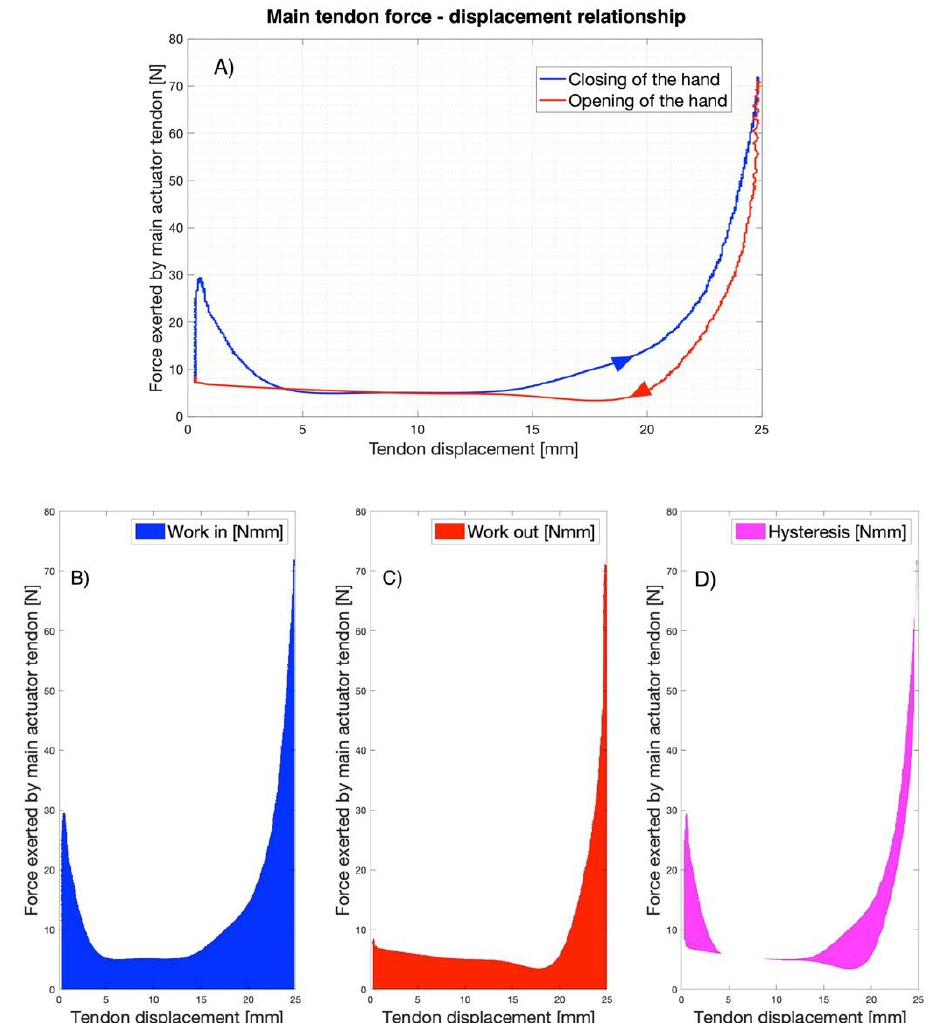
Figure 18. Main tendon force–displacement relationship ( A ) A whole cycle of hand closing (blue line) and opening (red line), the arrows indicate the direction of travel; ( B ) The blue area is the work required for closing the hand (work in); ( C ) The red area is the work returned by the hand during reopening (work out); ( D ) The magenta area is the dissipated energy per cycle. Table 4. Works for hand opening, closing and hysteresis [Nmm] of different hand prostheses. The acronym VO stands for voluntarily open, while VC stands for voluntarily closed. The hook prostheses are highlighted with a grey background.